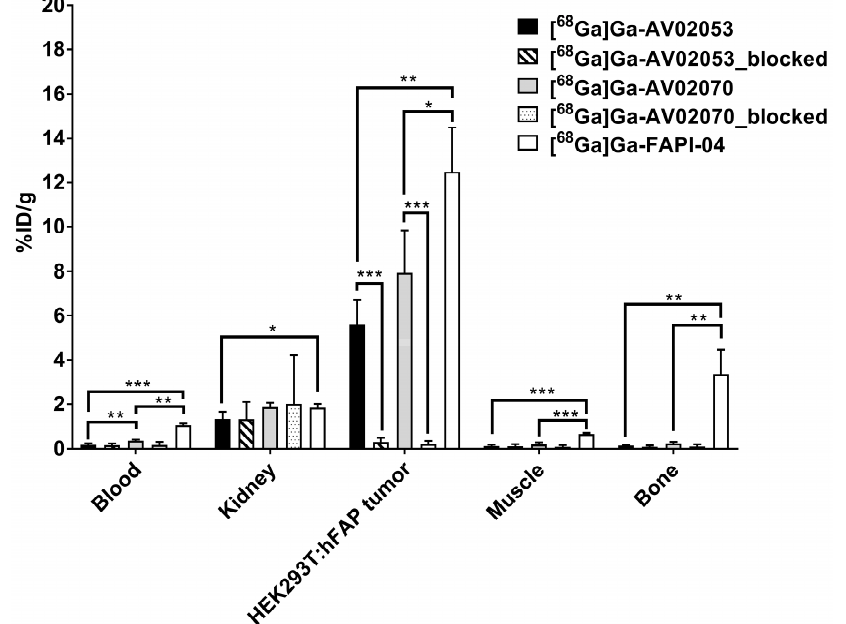
Figure 4. Biodistribution of [ 68 Ga]Ga-AV02053 and [ 68 Ga]Ga-AV02070 in HEK293T:hFAP tumor-bearing mice (n = 4) at 1 h post-injection with/without co-injection of FAPI-04 (250 µg). The biodistribution data for [ 68 Ga]Ga-FAPI-04 have been reported previously [31]. Error bars indicate standard deviations. Statistical significance was calculated using unpaired two-tailed t -test with the Holm–Sidak method. * p < 0.05, ** p < 0.01, *** p < 0.001.